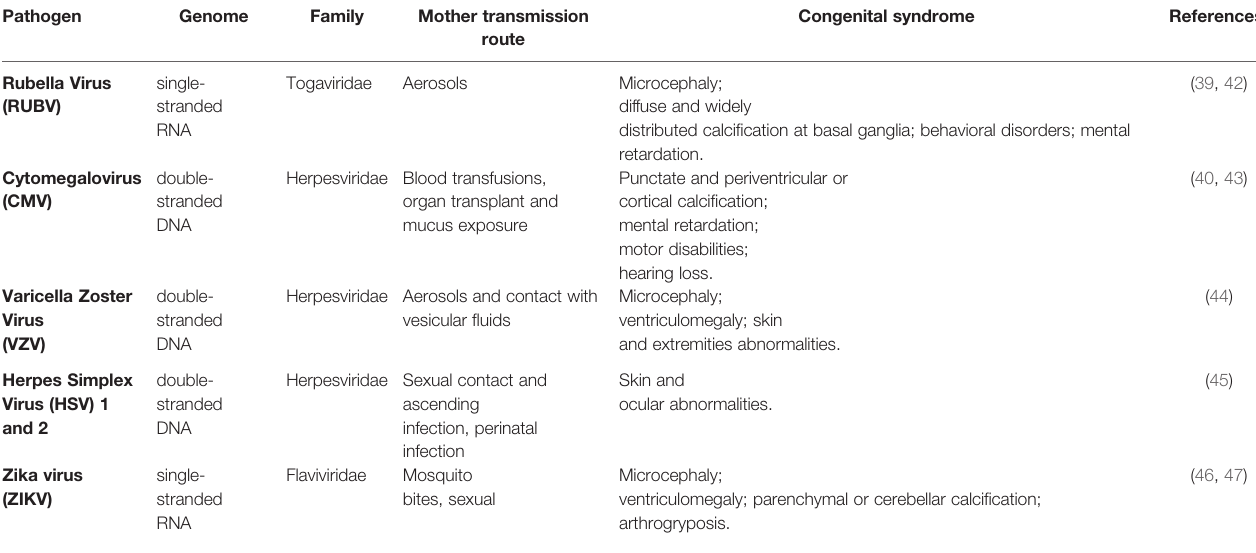
TABLE 1 | Main congenital syndromes associated with viral infections.